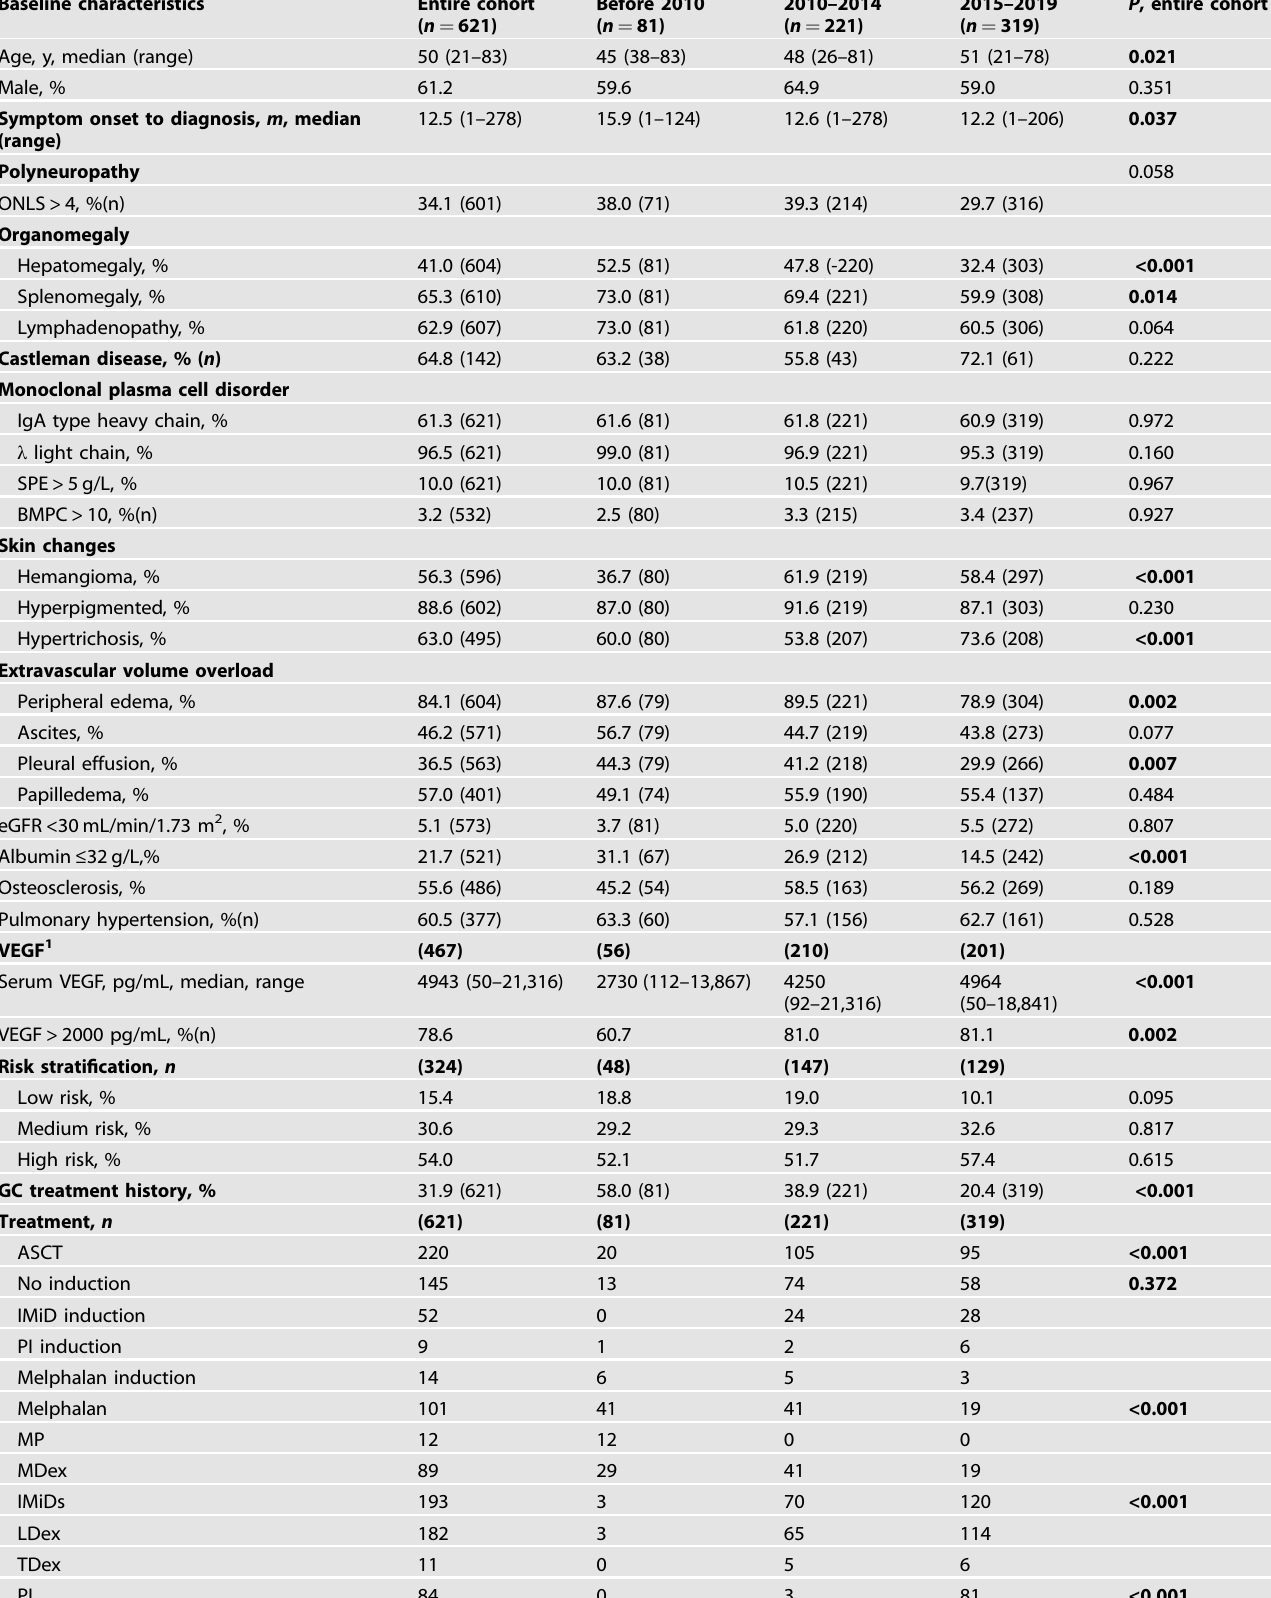
Table 1. Baseline and treatment characteristics of the entire cohort and by time